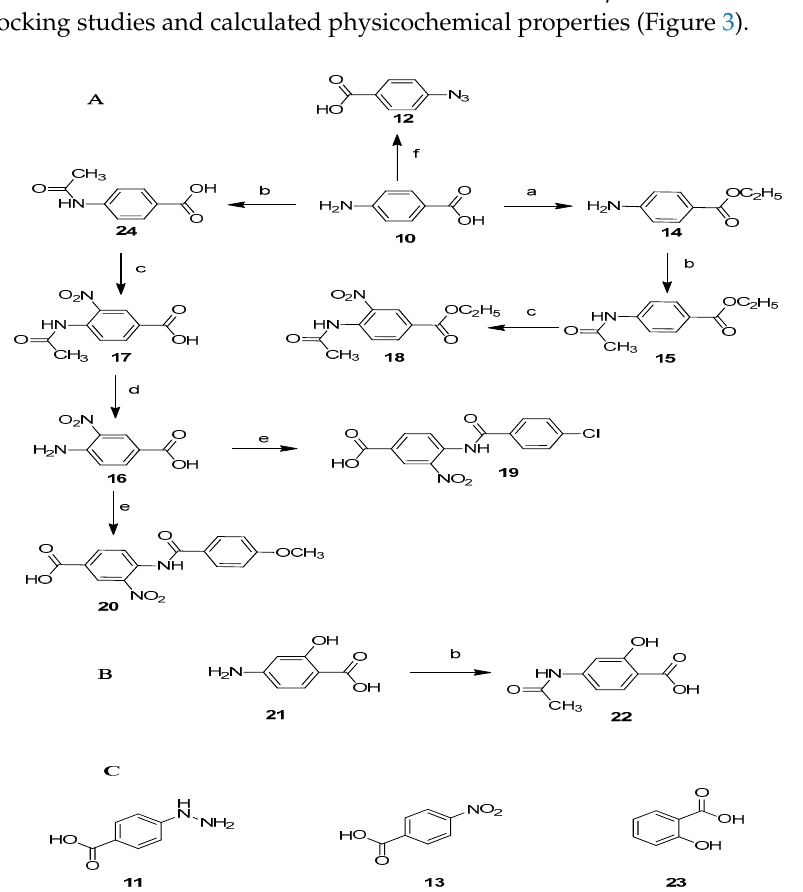
Figure 3. ( A , B ) Compounds designed and synthesized in this work. Reagents and condition : (a) dry CH 3 CH 2 OH, conc H 2 SO 4 , Δ ; (b) CH 3 CO 2 H/(CH 3 CO) 2 O, Δ ; (c) HNO 3 and conc H 2 SO 4 , Δ ; (d) H 2 SO 4 , Δ ; (e) p -ClC 6 H 4 COCl, Et 3 N ( 19 ), p -CH 3 OC 6 H 4 COCl, Et 3 N ( 20 ); (f) HCl, NaNO 2